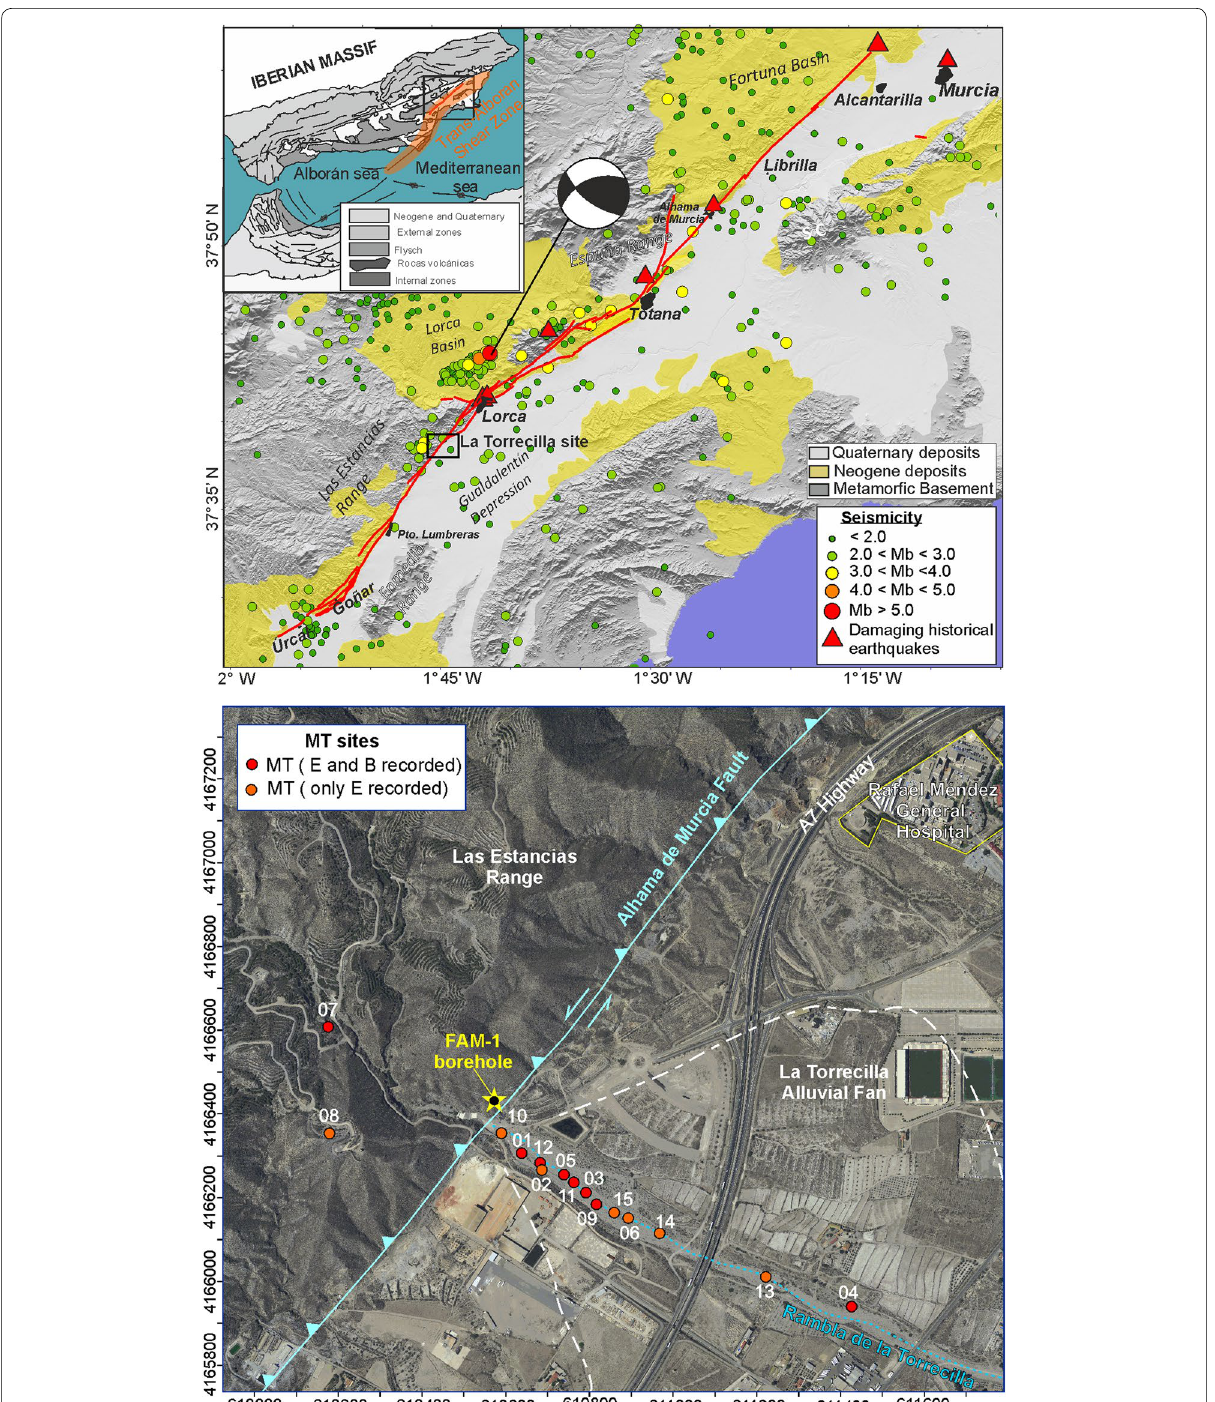
Fig. 1 Top: inset and geological map of the Alhama de Murcia Fault (red trace), epicenters of instrumental and historical earthquakes ( M > 1; between 500 a . d . and 2012) and the Mw 5.2, 2011 Lorca earthquake focal mechanism. Black rectangle limits the area of the Torrecilla Survey (modified from Martínez‑Díaz et al. 2016a). Bottom: aerial view of the Rambla de la Torrecilla area and location of MT sites acquired. The blue line is the main trace of the Alhama de Murcia Fault (Source: Google